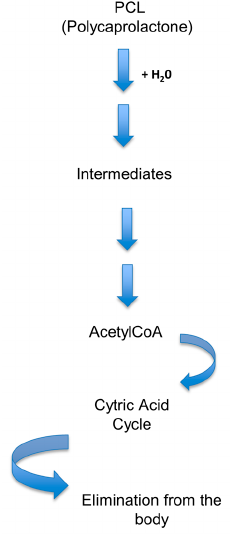
Figure 7. PCL degradation process.